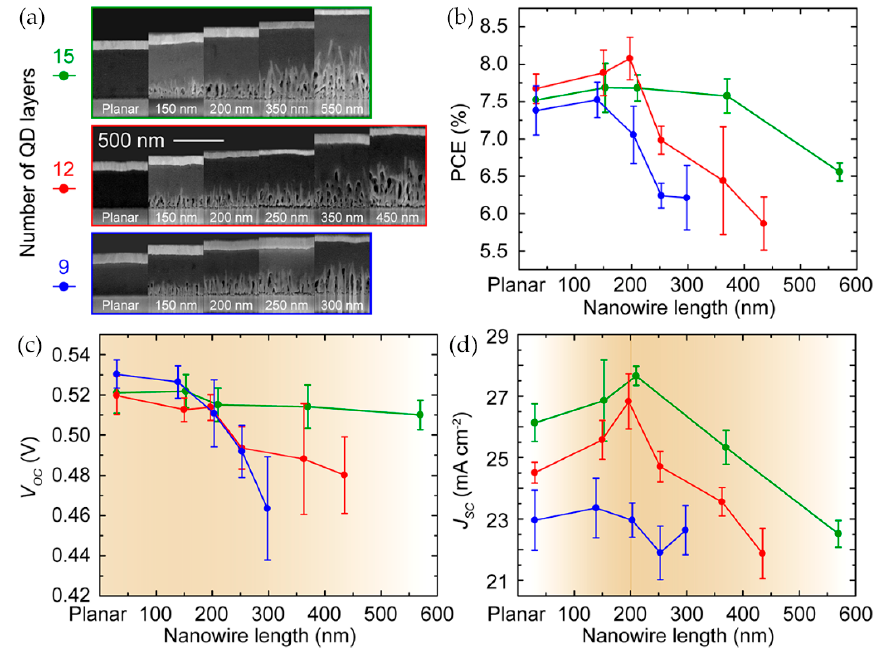
Figure 6. Performance variations of devices with different characteristics: ( a ) SEM images of devices with different NW lengths and CQD layers; ( b ) PCE, ( c ) V OC , and ( d ) J SC for sets of devices with different conditions [91].